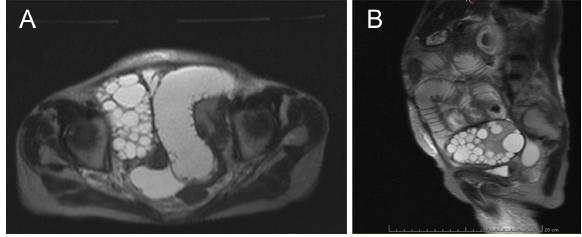
Figure 14. Axial (A) and sagittal (B) T2-weighted magnetic resonance image showing cystic mass with daughter cysts in the right